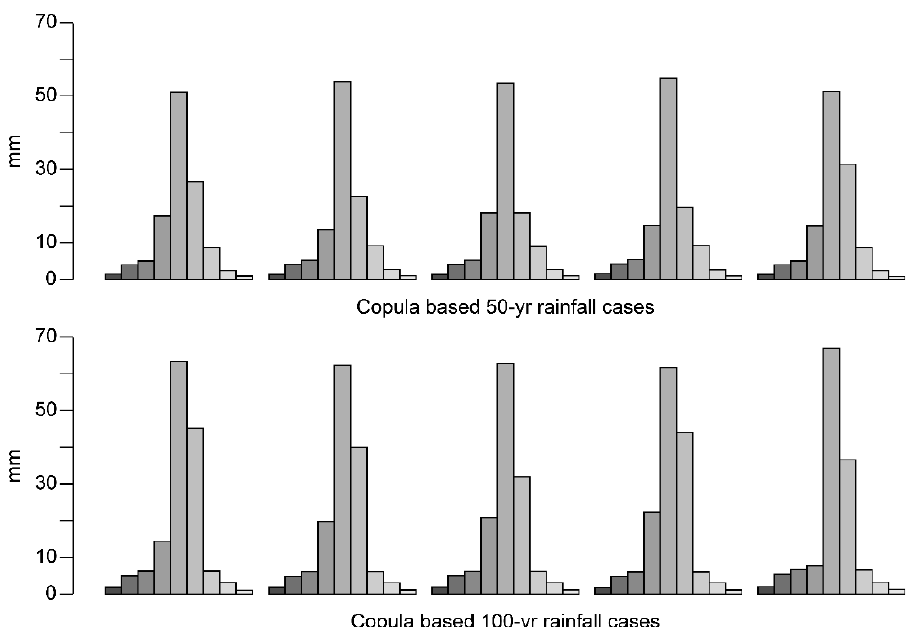
Figure 8. Five rainfall cases for 50-year and 100-year return periods from copula-based rainfall analysis. The y-axis is rainfall amount, the x-axis is rainfall duration; 9-hour rainfall events are designed.